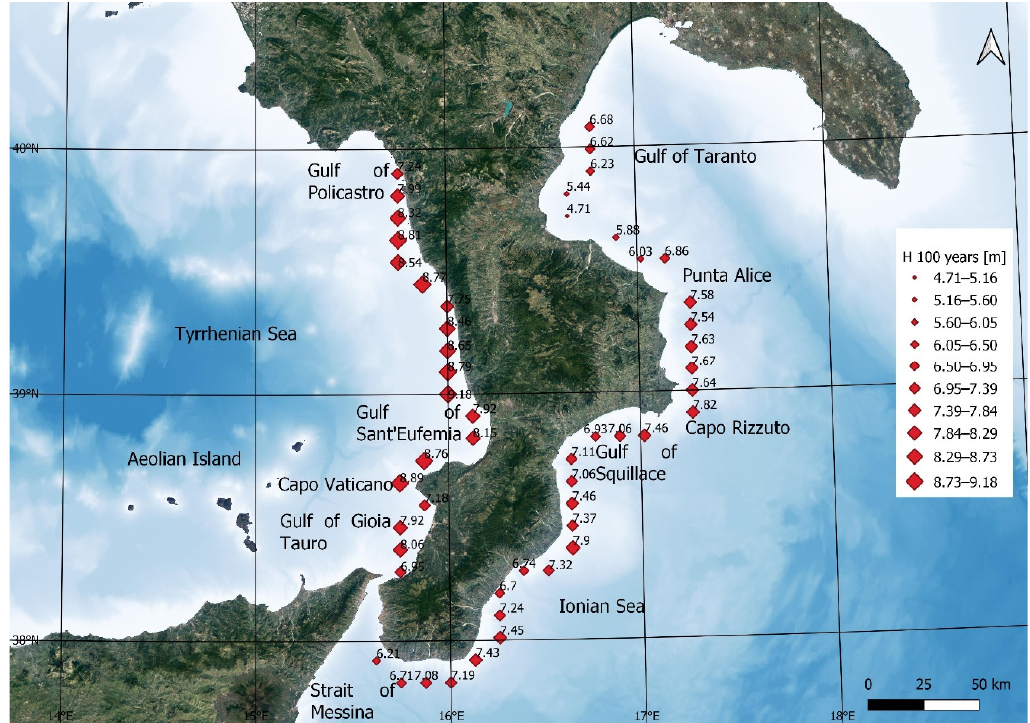
Figure 6. Significant wave height of return period of 100 years h s 100 values. The range between the minimum and the maximum values has been divided into 10 intervals of the same width.